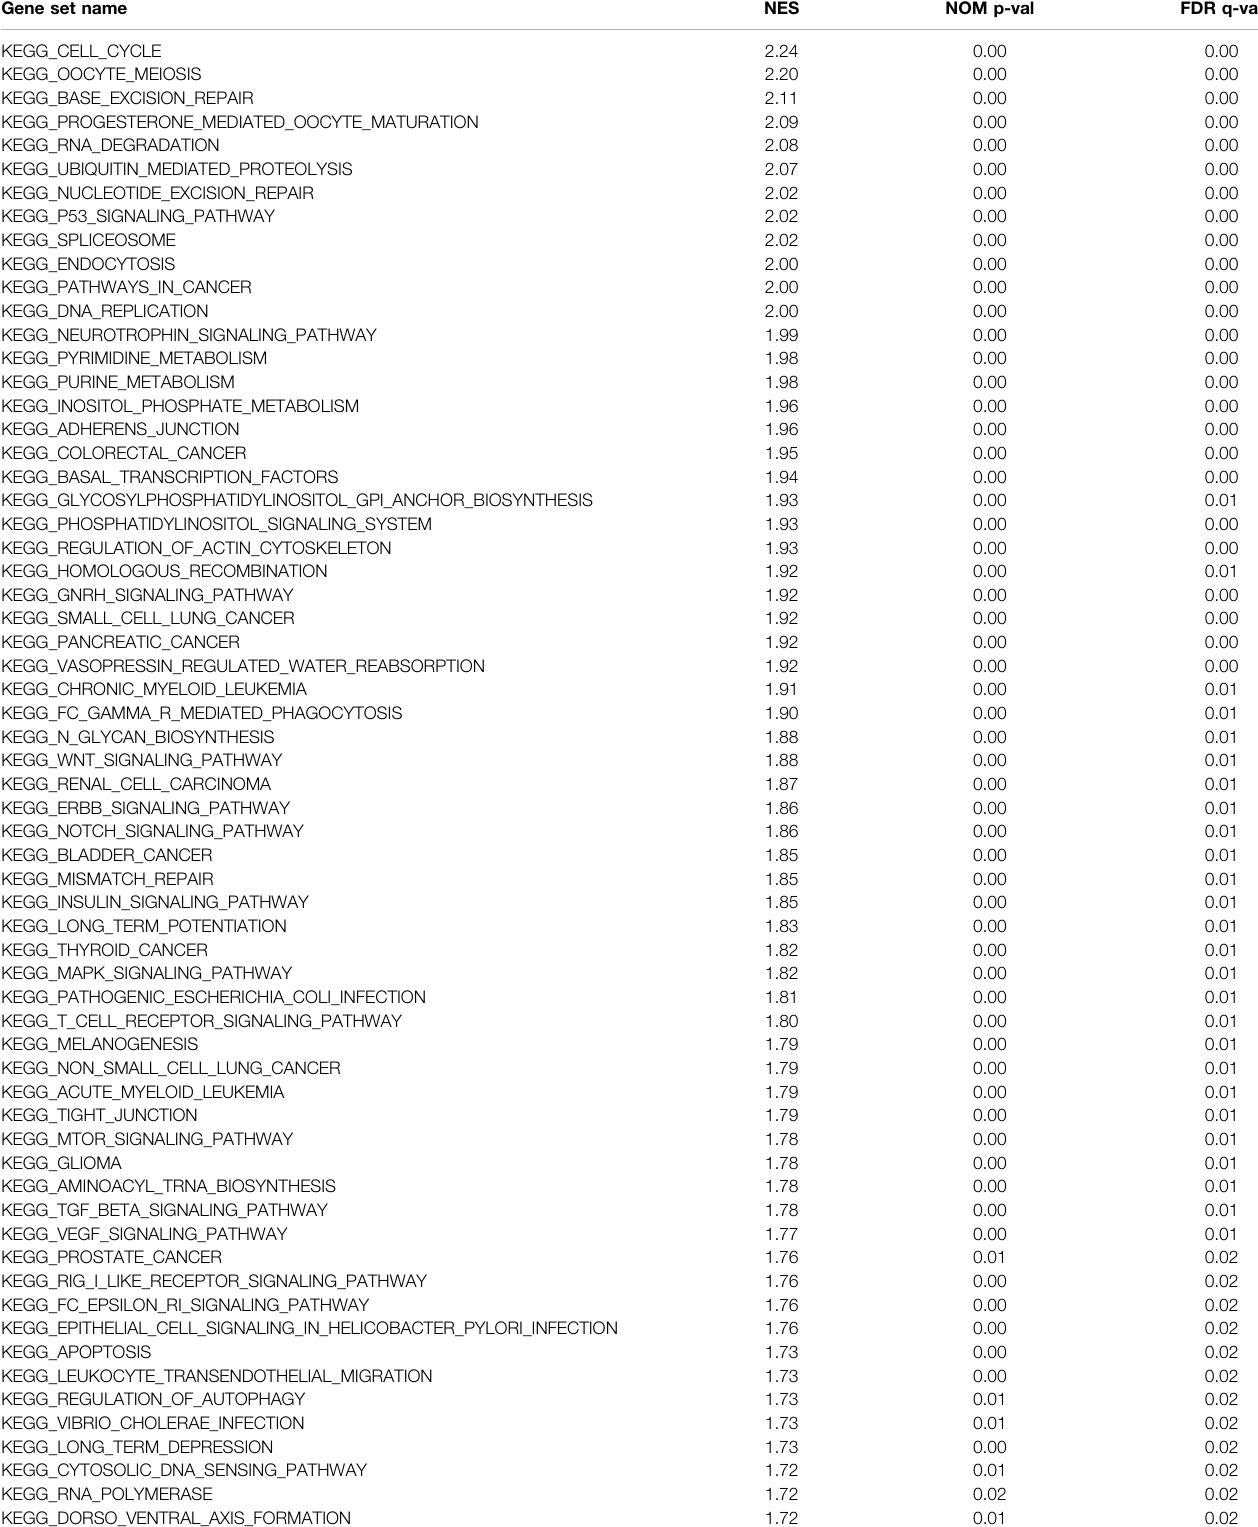
TABLE 4 | KEGG pathways in the high DEPDC1B expression phenotype. Gene set